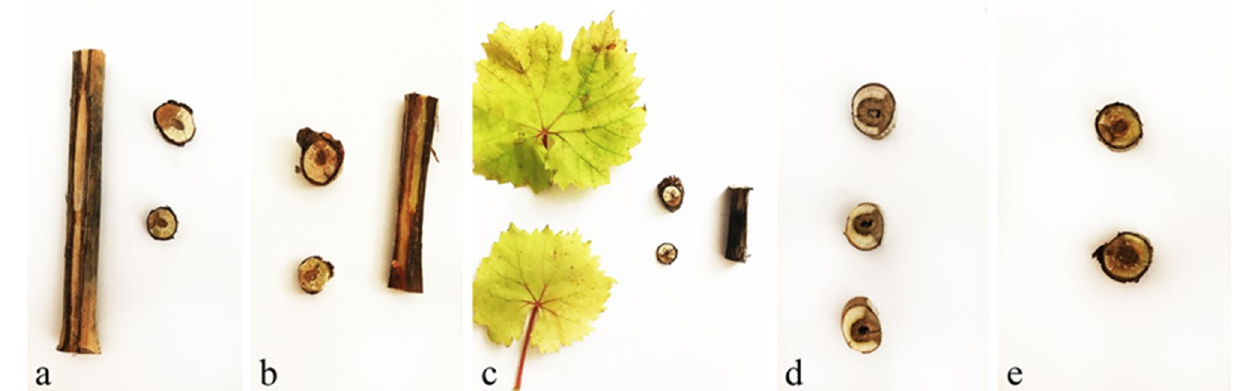
Figure 2. Disease symptoms caused by pathogenic fungi on grapevines in greenhouse conditions. ( a ) Curvularia spicifera . ( b ) Kalmusia variispora . ( c ) Neoscytalidium hyalinum . ( d ) Pheoacremonium minimum . ( e ) Truncatella angustata